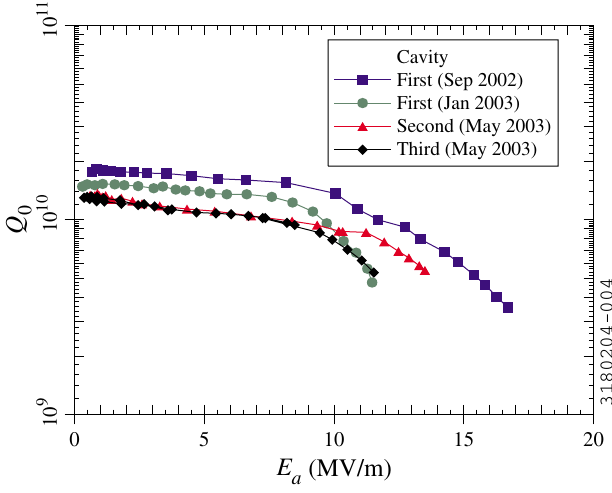
FIG. 7. (Color) Measured dependence of the quality factor on the accelerating gradient for the 6-cell cavity prototypes. All measurements were done at a bath temperature of 2